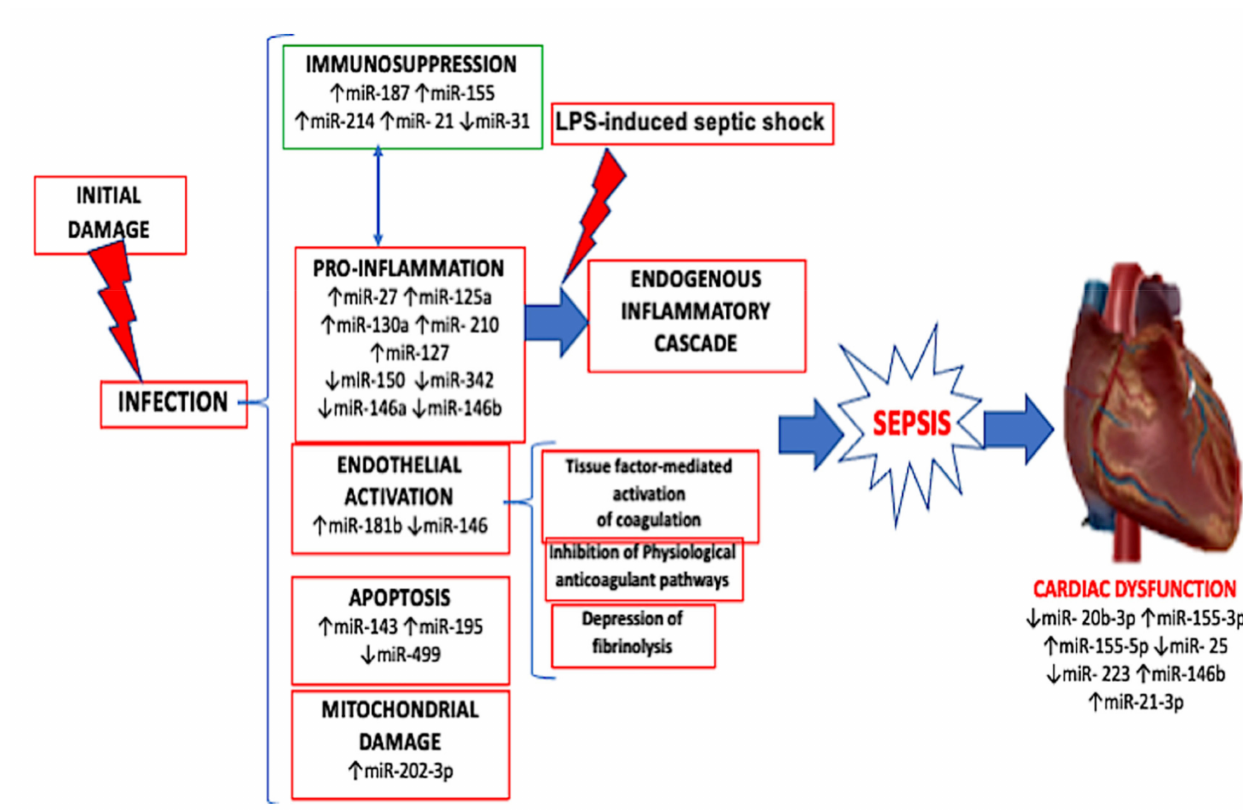
Figure 2. Mechanism of action of the activation of the major players of cardiac dysfunction induced by sepsis with up and down regulation of miRNAs involved in the mechanism of infection.